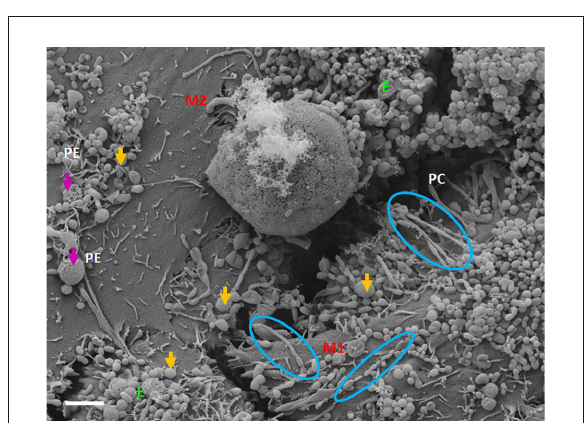
FIGURE5 The expression of TF-exosomes on the bEnd5 plasmalemma is requisite for TUNT formation for the BECs monolayers. The above micrograph is an illustration of cell-cell communication promoted by the formation of two types of membrane-bound exosomes and the primordial stages of TUNT development and the lateral pervasion of TUNTs within the PC space following exosome accumulation on the surface of a bEnd5 cell. M1 denotes the cell membrane from which the TUNT originates and M2 denotes the target cell membrane, The purple arrows indicate porous NTF-exosomes (PE), and the orange arrows indicate TF-exosomes (E), which induce TUNT formation accumulating on BEC membrane surfaces, the blue circles indicate TF-exosome-induced TUNT formation. Scale bar = 2,000